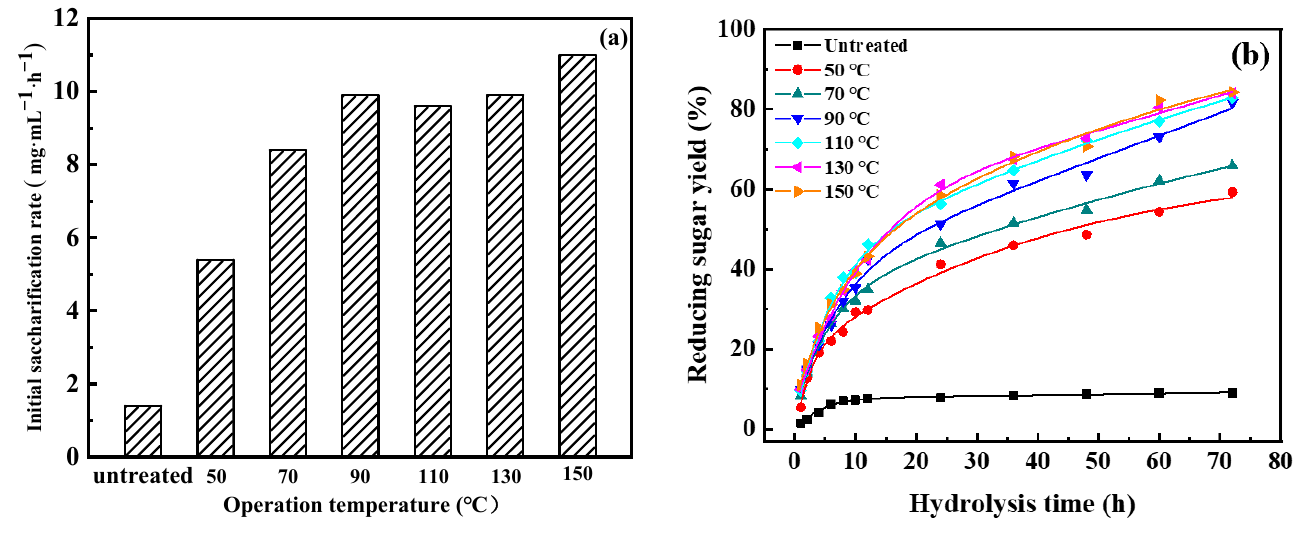
Figure 6. E ff ect of operation temperature on enzymatic hydrolysis: ( a ) initial sacchari fi cation rate, Figure 6. Effect of operation temperature on enzymatic hydrolysis: ( a ) initial saccharification rate, and ( b ) reducing sugar yield. and ( b ) reducing sugar